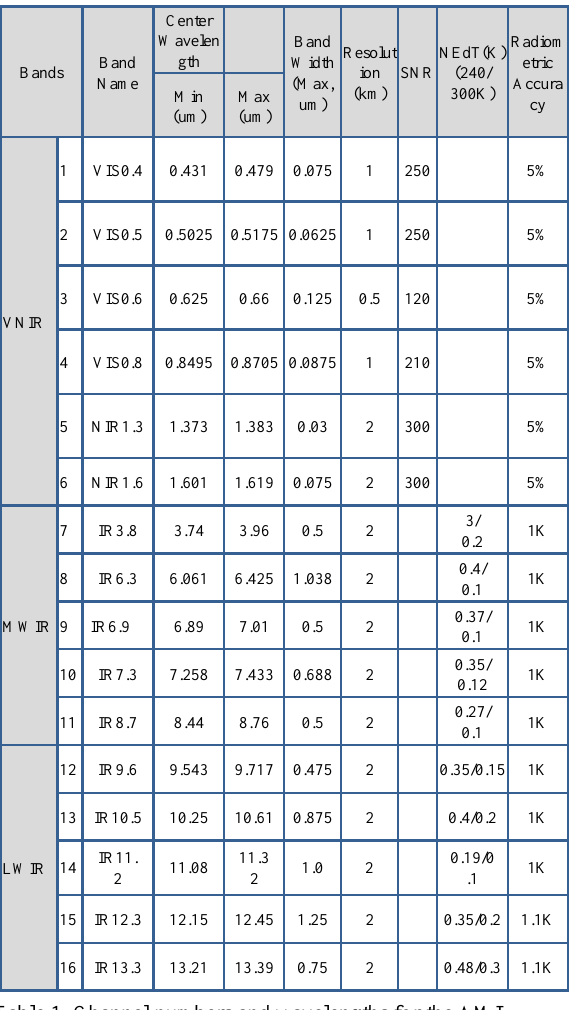
Table 1. Channel numbers and wavelengths for the AMI.